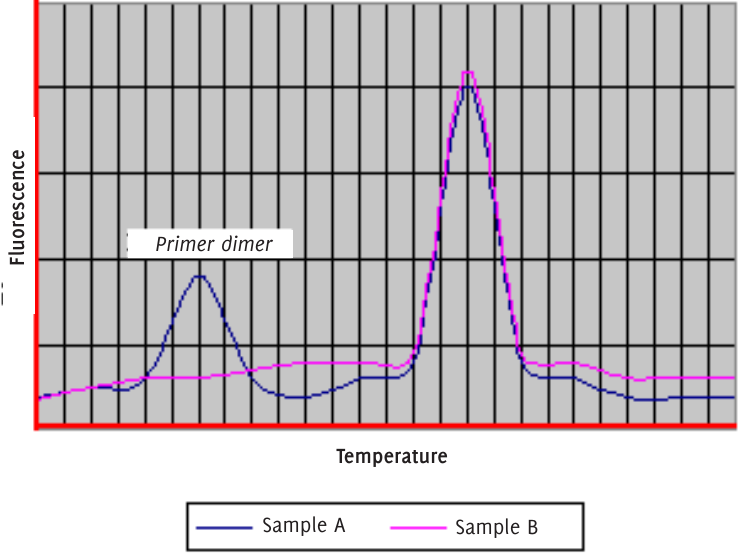
Figure 3. Primer dimer can be observed in RT-PCR when gene expression is low and can be easily resolved by increasing concentration of the target template.